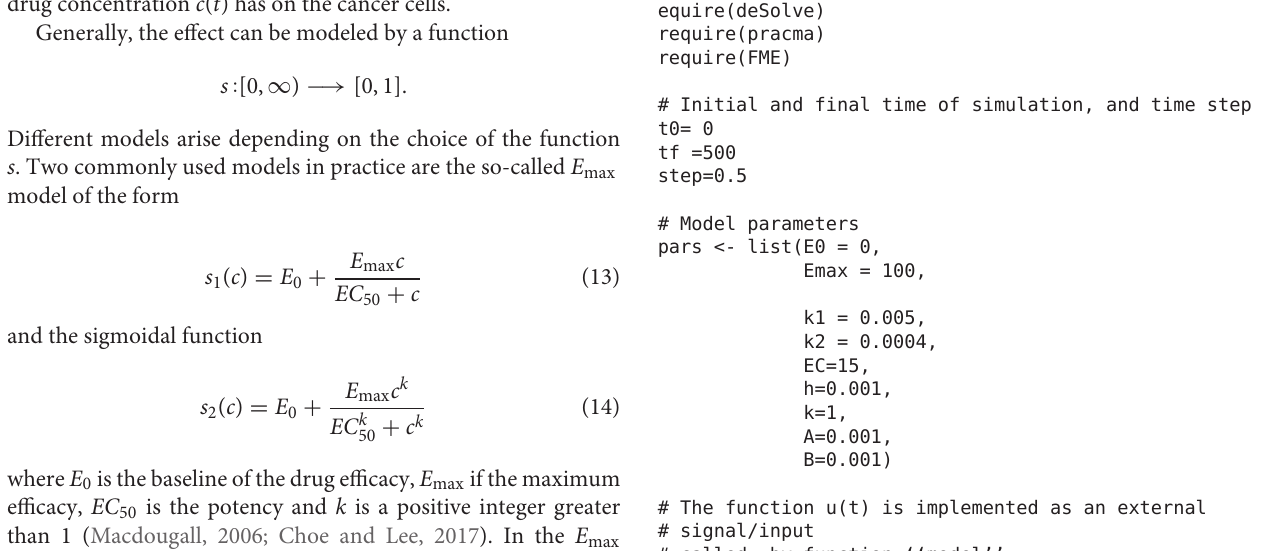
TABLE 1 | R script implementing the model described by the Equations (15)–(16). # Upload libraries